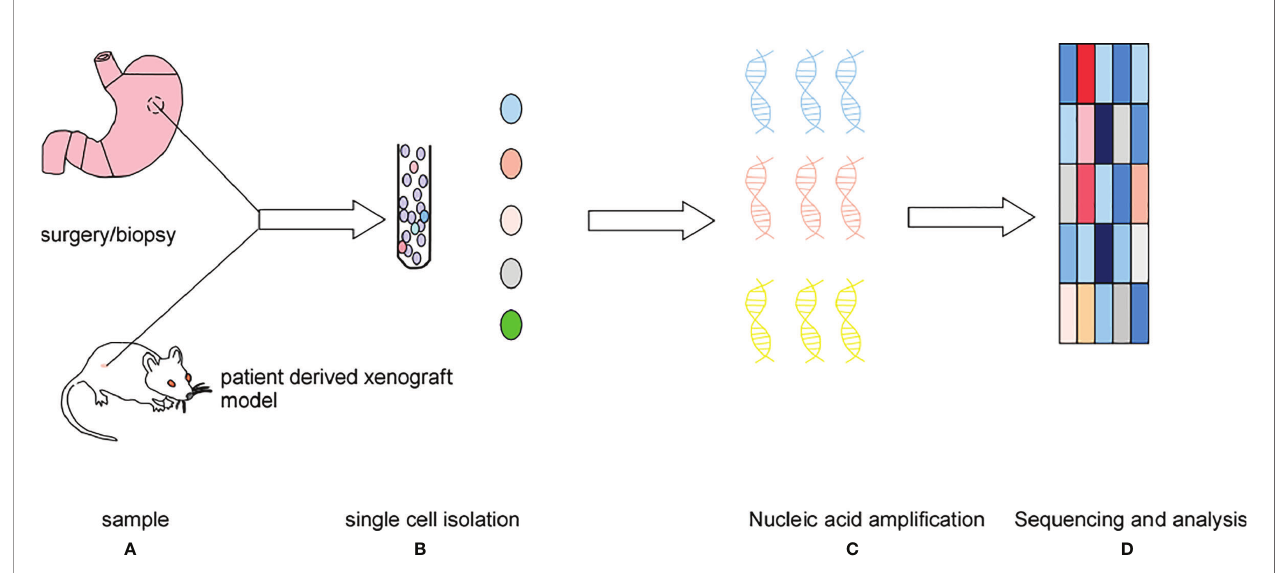
FIGURE 1 | The main processes: (A) sample acquisition, (B) cell isolation, (C) single-cell DNA or RNA ampli fi cation, (D) high-throughput sequencing and single-cell sequencing data correction and